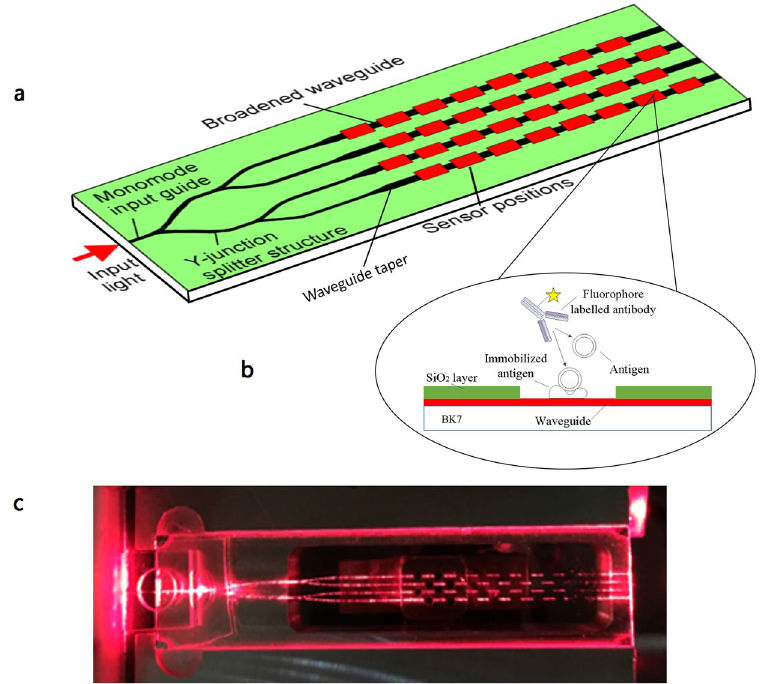
Figure 1. ( a ) Schematic diagram of the sensor layout; ( b ) A cross-sectional view along one of the sensing patches, showing the waveguide, isolation layer and location of the surface chemistry; ( c ) A photographic image of light propagation along the waveguide chip (Photo by Lanhua